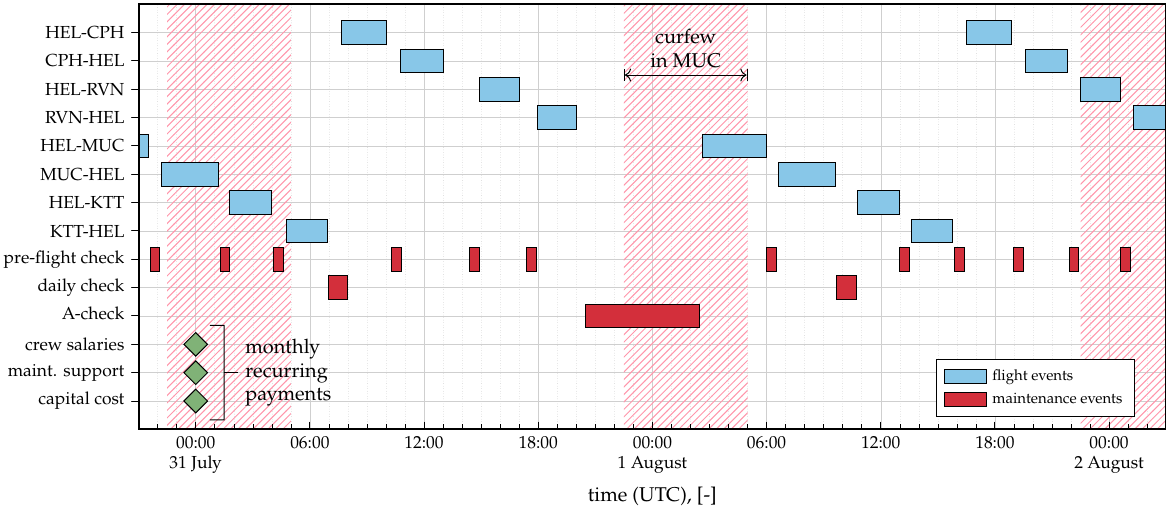
Figure 5. Excerpt of an event calendar of a Helsinki (HEL) based short range aircraft including flight events (blue), maintenance events (red), monthly recurring payments (green), and the takeoff and landing curfews from the Munich (MUC) airport